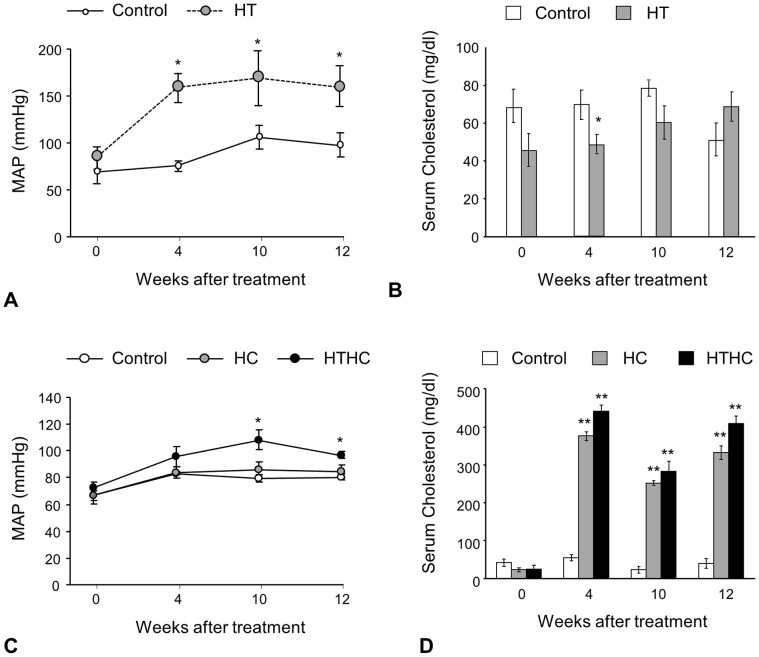
Mean arterial pressure and serum cholesterol levels in rabbits.(A) Mean arterial pressure in hypertension only rabbits. (B) Serum cholesterol levels in hypertension only rabbits. (C) Mean arterial pressure in hypercholesterolemia plus sham- and hypertension plus hypercholesterolemia rabbits. (D) Serum cholesterol levels in hypercholesterolemia plus sham- and hypertension plus hypercholesterolemia rabbits. H: Hypertension only. HC: Hypercholesterolesterolemia plus sham operation. HTHC: Hypertension plus hypercholesterolemia. MAP: mean arterial pressure. Data are expressed as mean ± SEM. *p<0.05, **p<0.01 vs. control (Student’s t-test in A,B; repeated measure ANOVA followed by Tukey test in C,D).